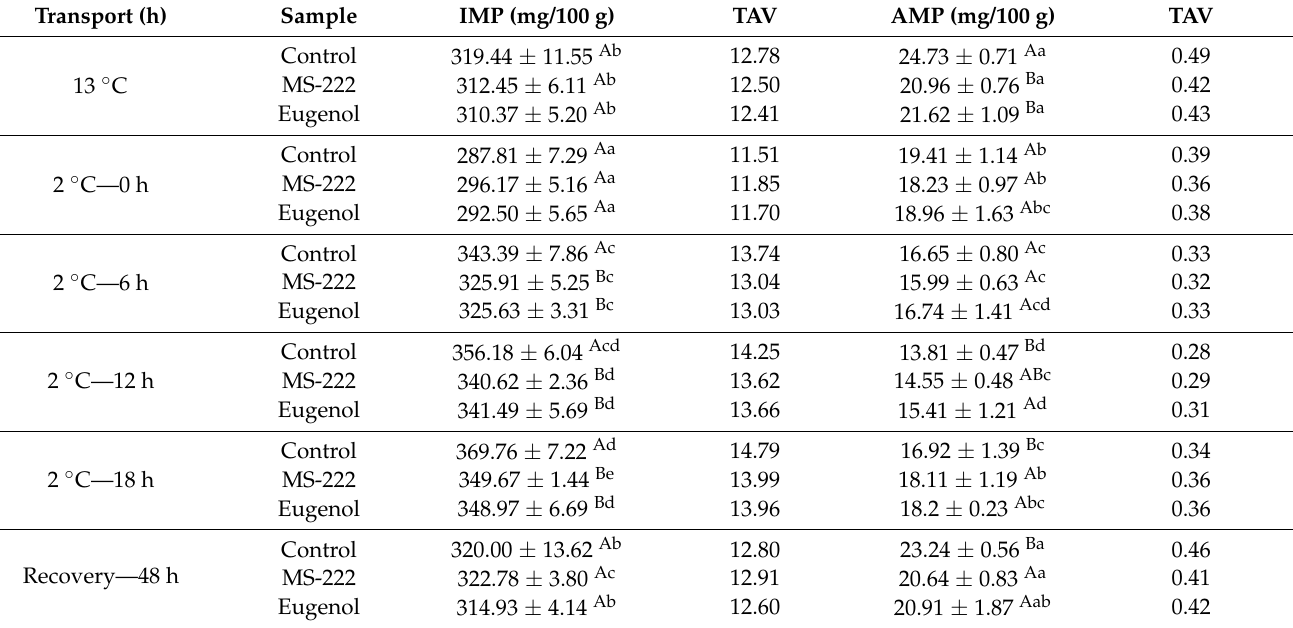
Table 2. Changes in nucleotides of turbot during waterless